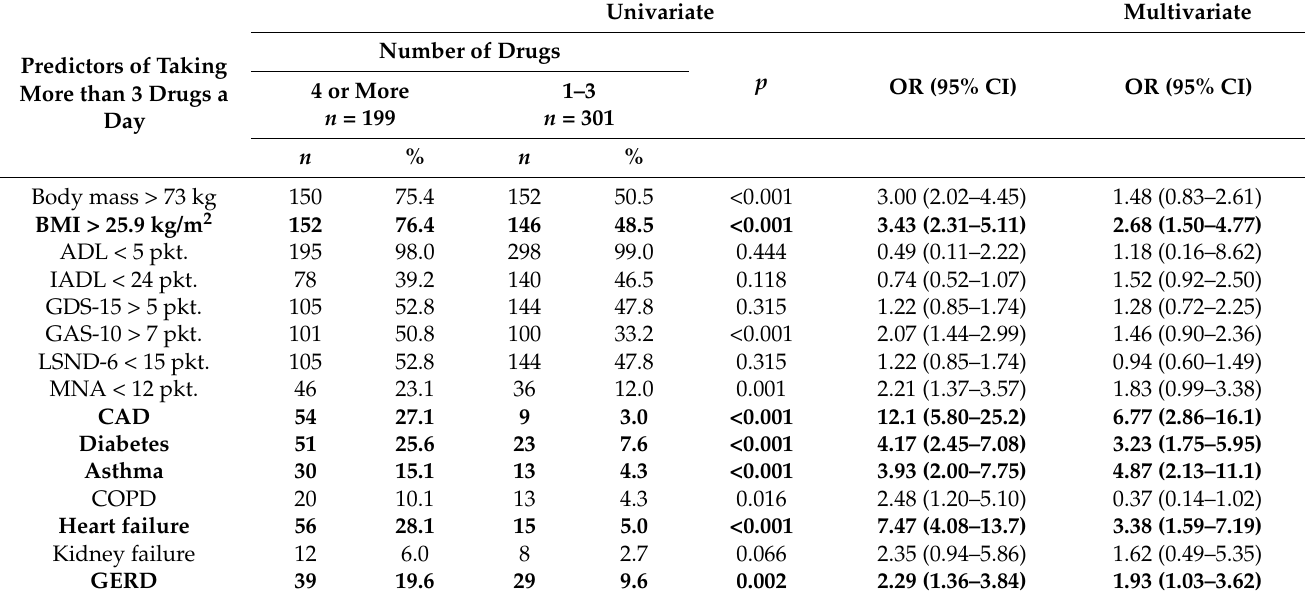
Table 4. Results of logistic regression of univariate and multivariate sociodemographic, clinical and mental parameters with the use of more than 3 drugs a